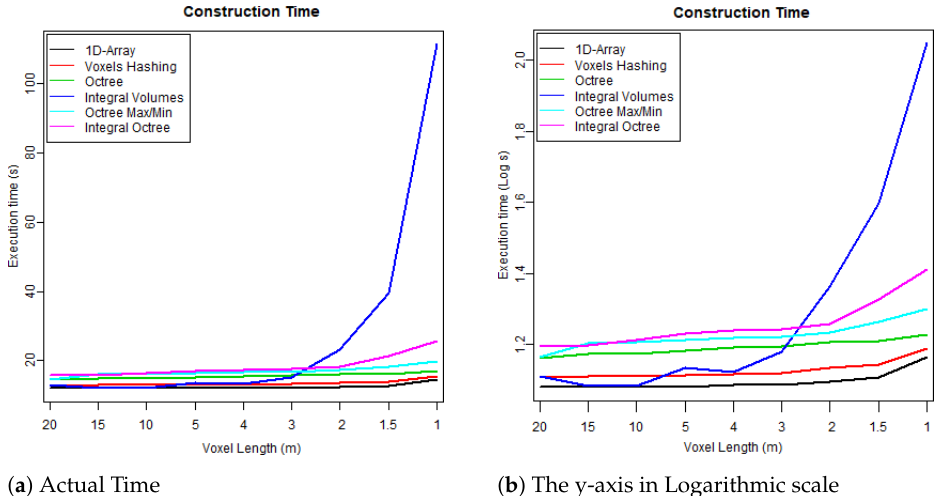
Figure 9. Time required to build each data structure by voxelising the FW LiDAR samples (Table 4).